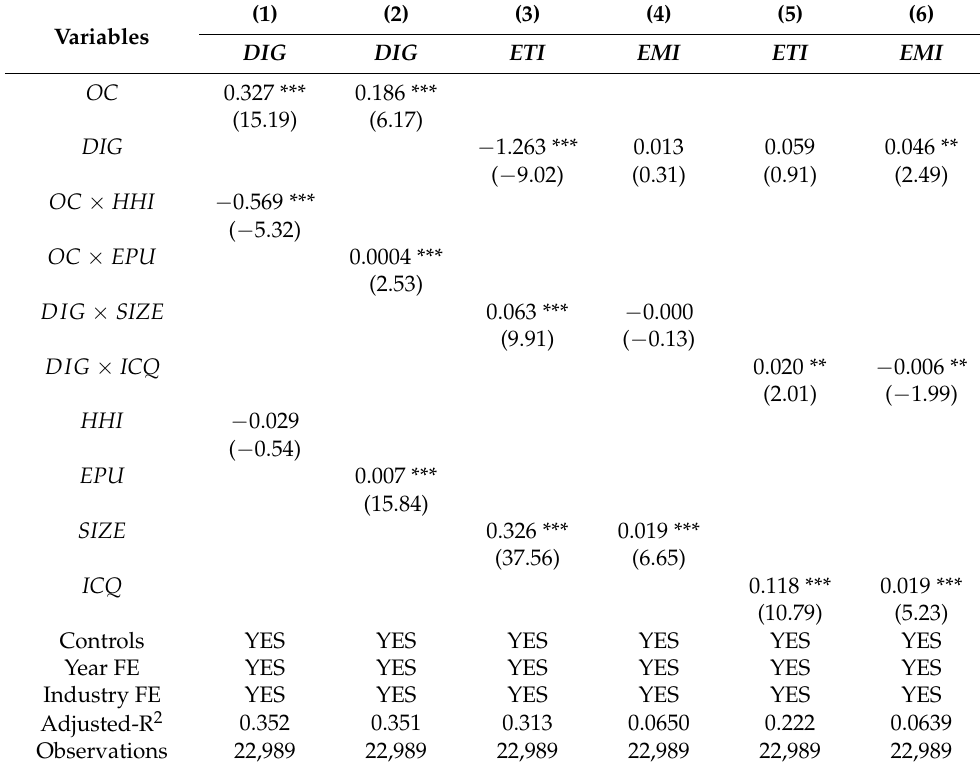
Table 8. Moderating effect